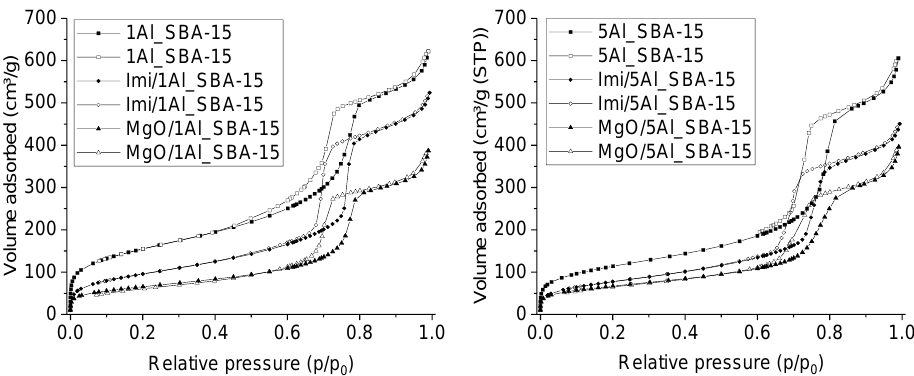
Figure 2. Differential heat of adsorption as a function of NH 3 uptake at 80 °C for 1Al_SBA-15 and 5Al_SBA-15. For comparison, data for pure silica SBA-15 are also reported.